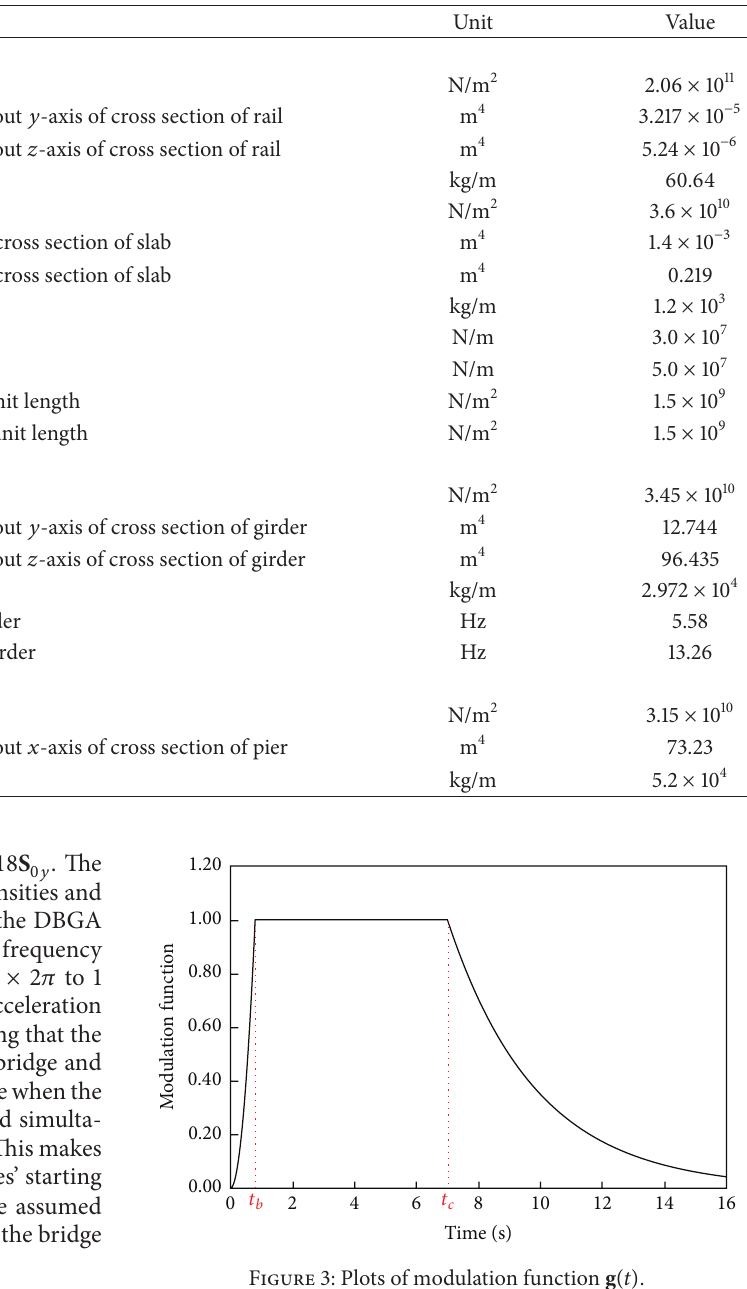
Table 1: Major parameters for slab track and bridge.